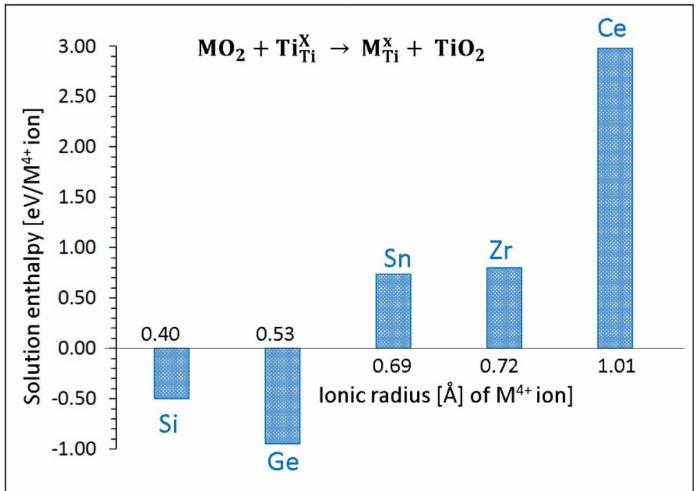
Figure 7. Solution enthalpies of MO 2 with respect to the ionic radius of M 4 + at the Ti